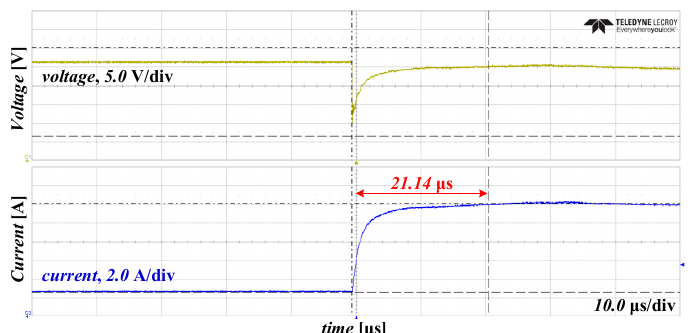
Figure 19. Experiment result for dynamic response: Step B → C (Case 2).